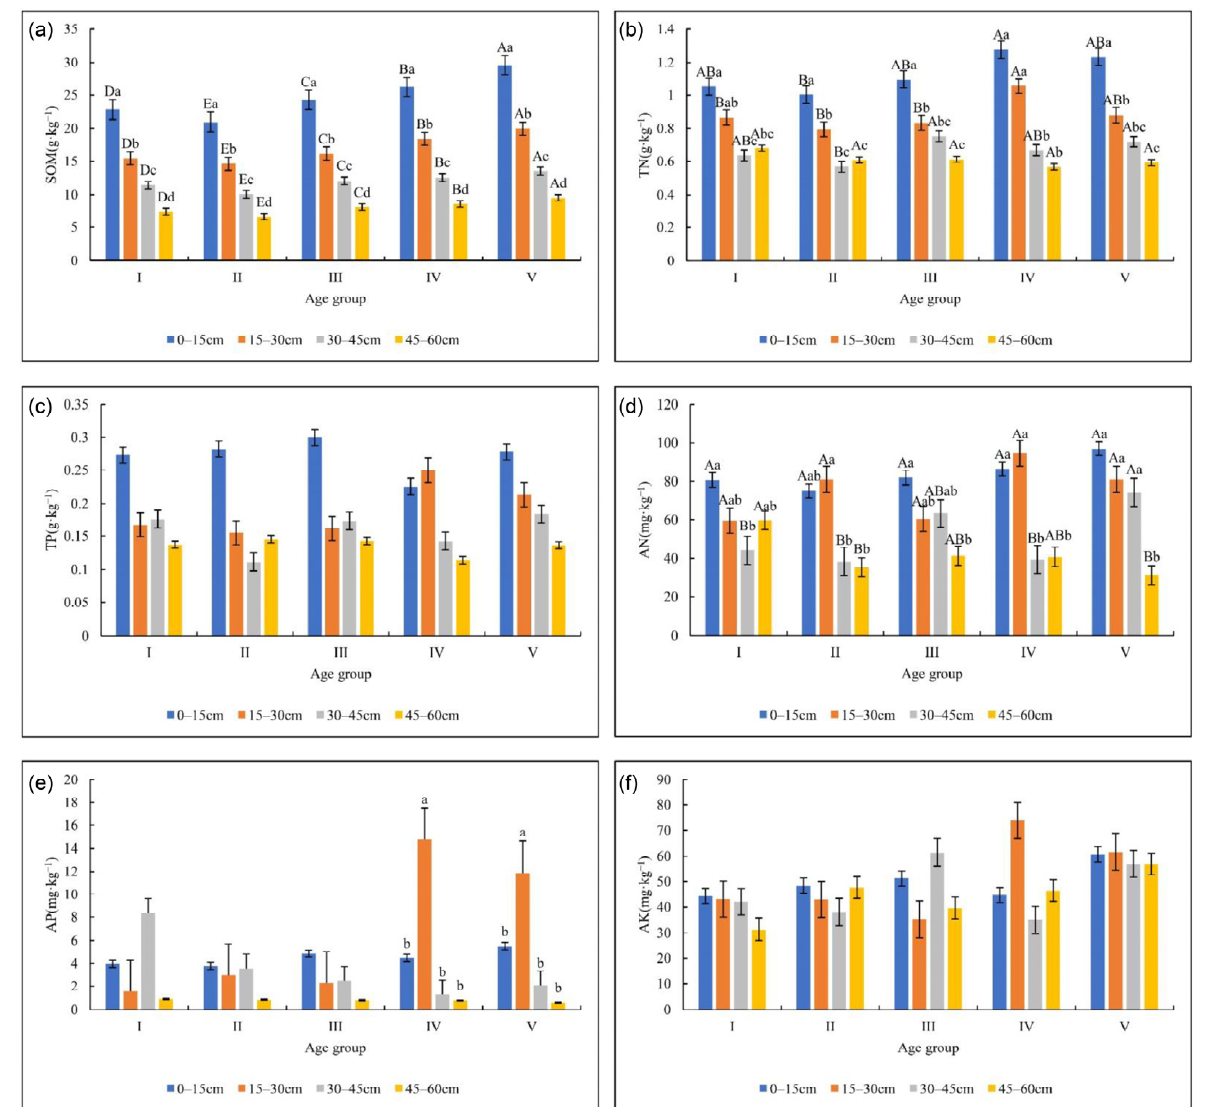
Figure 1. Soil nutrient contents change with soil depth in different age group stands. Note: ( a ) represents SOM, ( b ) represents soil TN, ( c ) represents soil TP, ( d ) represents soil AN, ( e ) represents soil AP, and ( f ) represents soil AK in figure. Different upper-case letters in the graphs indicate significant differences between the same soil layers in different age groups ( p < 0.05), while lower-case letters indicate significant differences between different soil layers in the same age group stand ( p < 0.05) in the figure.